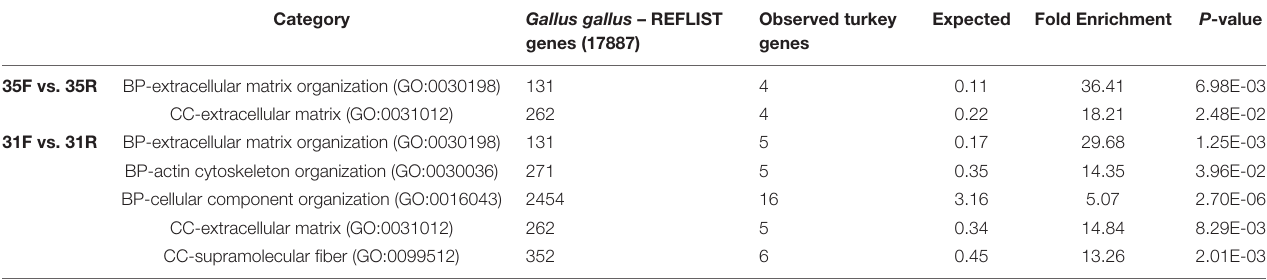
TABLE 5 | Summary of PANTHER Overrepresentation Test of the parental genes of differentially expressed circRNAs (DECs) in between-line comparisons of turkey poults after heat exposure 1 .